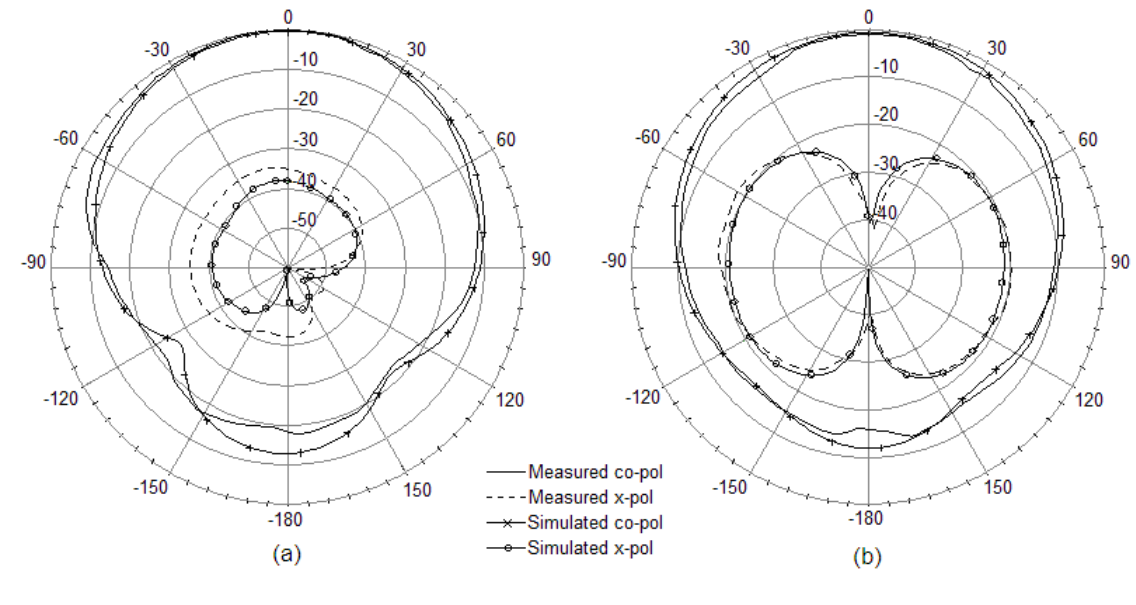
Figure 8. Measured and simulated radiation patterns. ( a ) E-plane. ( b )